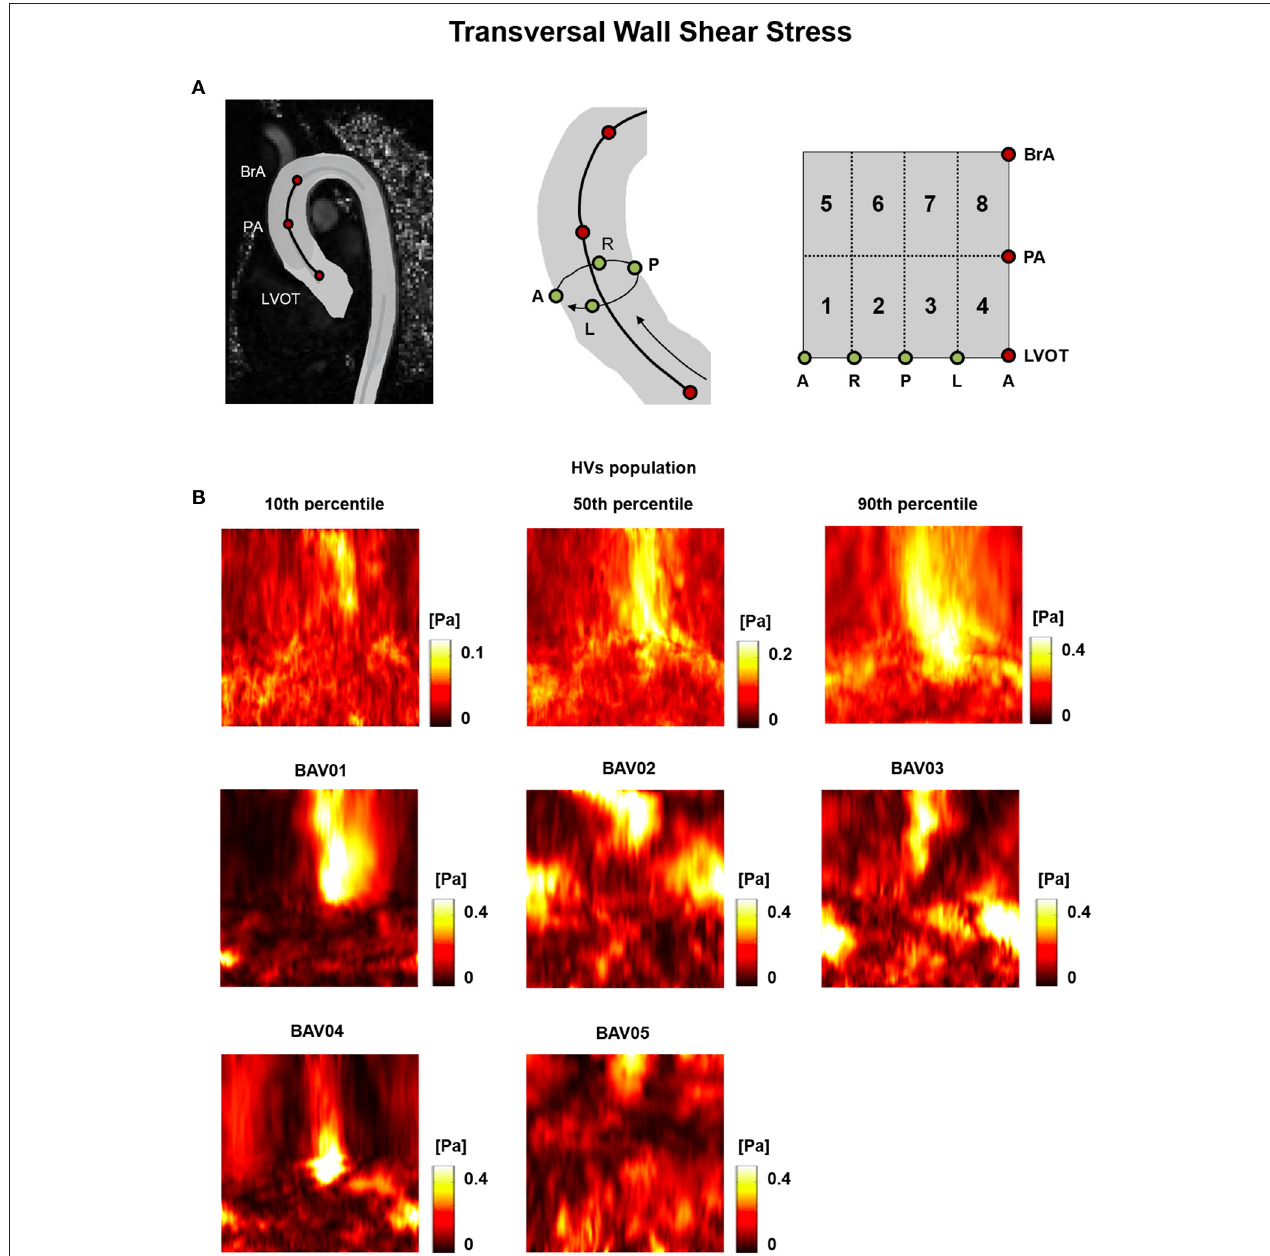
FIGURE 8 | (A) The 2D template detailed in Figure 3 is reported for the sake of clarity. (B) Transversal WSS (TransWSS) heat maps for HVs (represented as 10th, 50th, and 90th percentiles) and for each BAV patient obtained at peak systole.